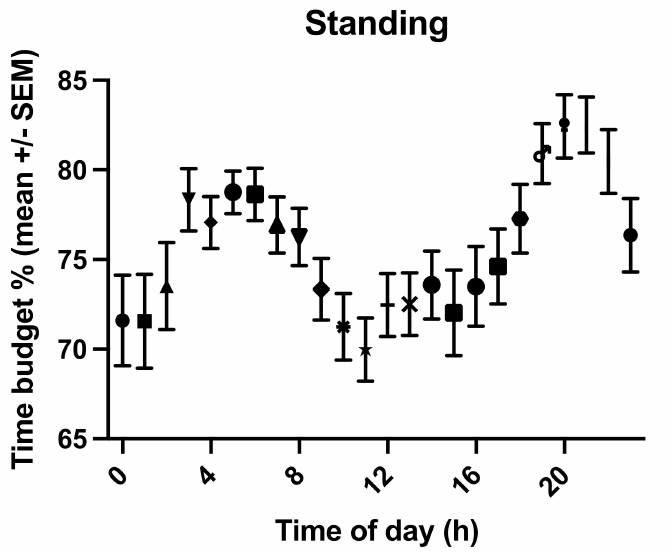
Figure 9. Graph of the standing time budget (mean % of 24 h +/ − SEM) throughout the day with a peak in standing times in the morning and